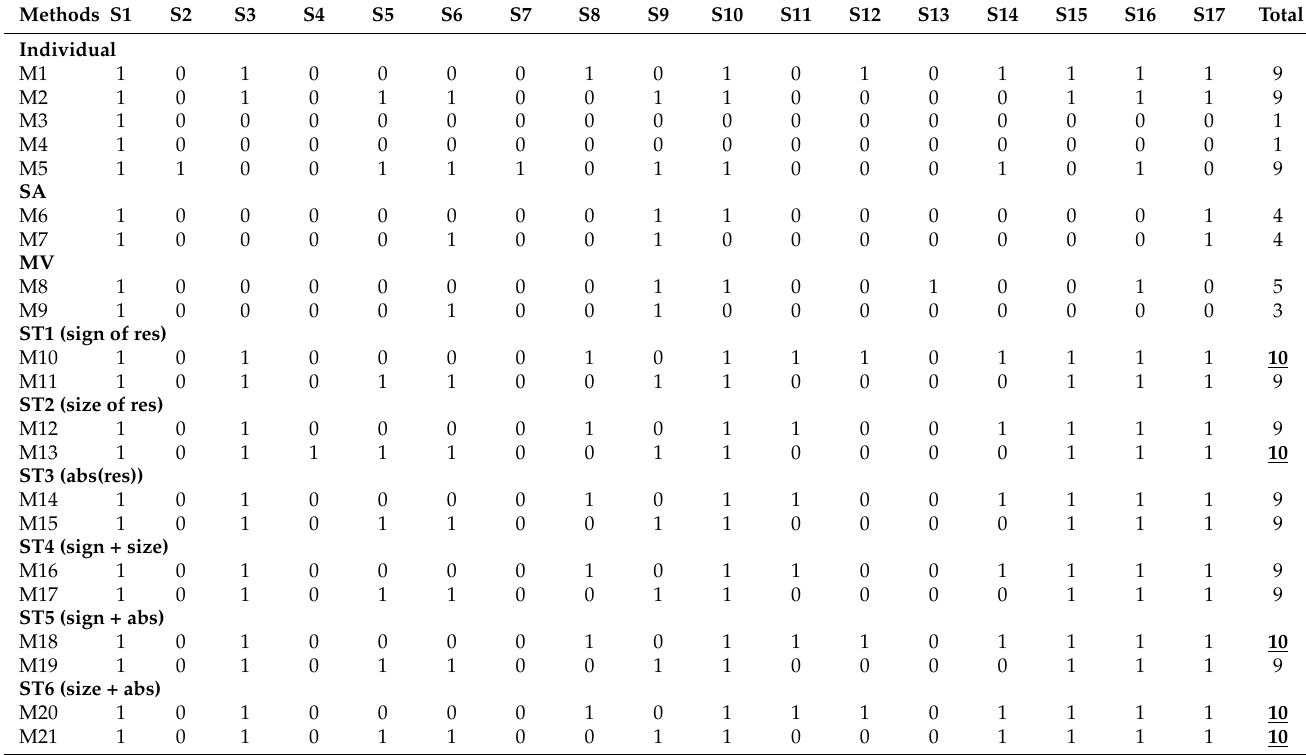
Table 17. MCS test for out-of-sample in tourism demand volatility forecasting using absolute forecast